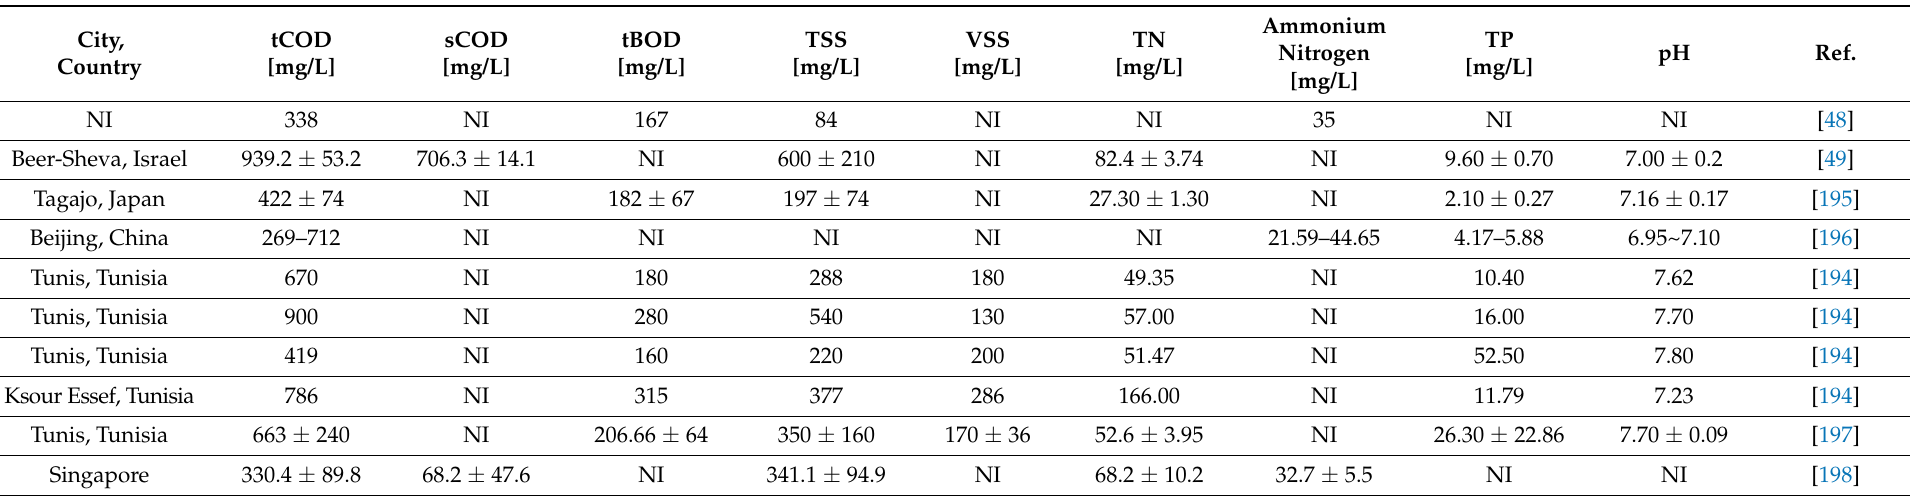
Table 5. The characteristics of real domestic wastewaters treated in